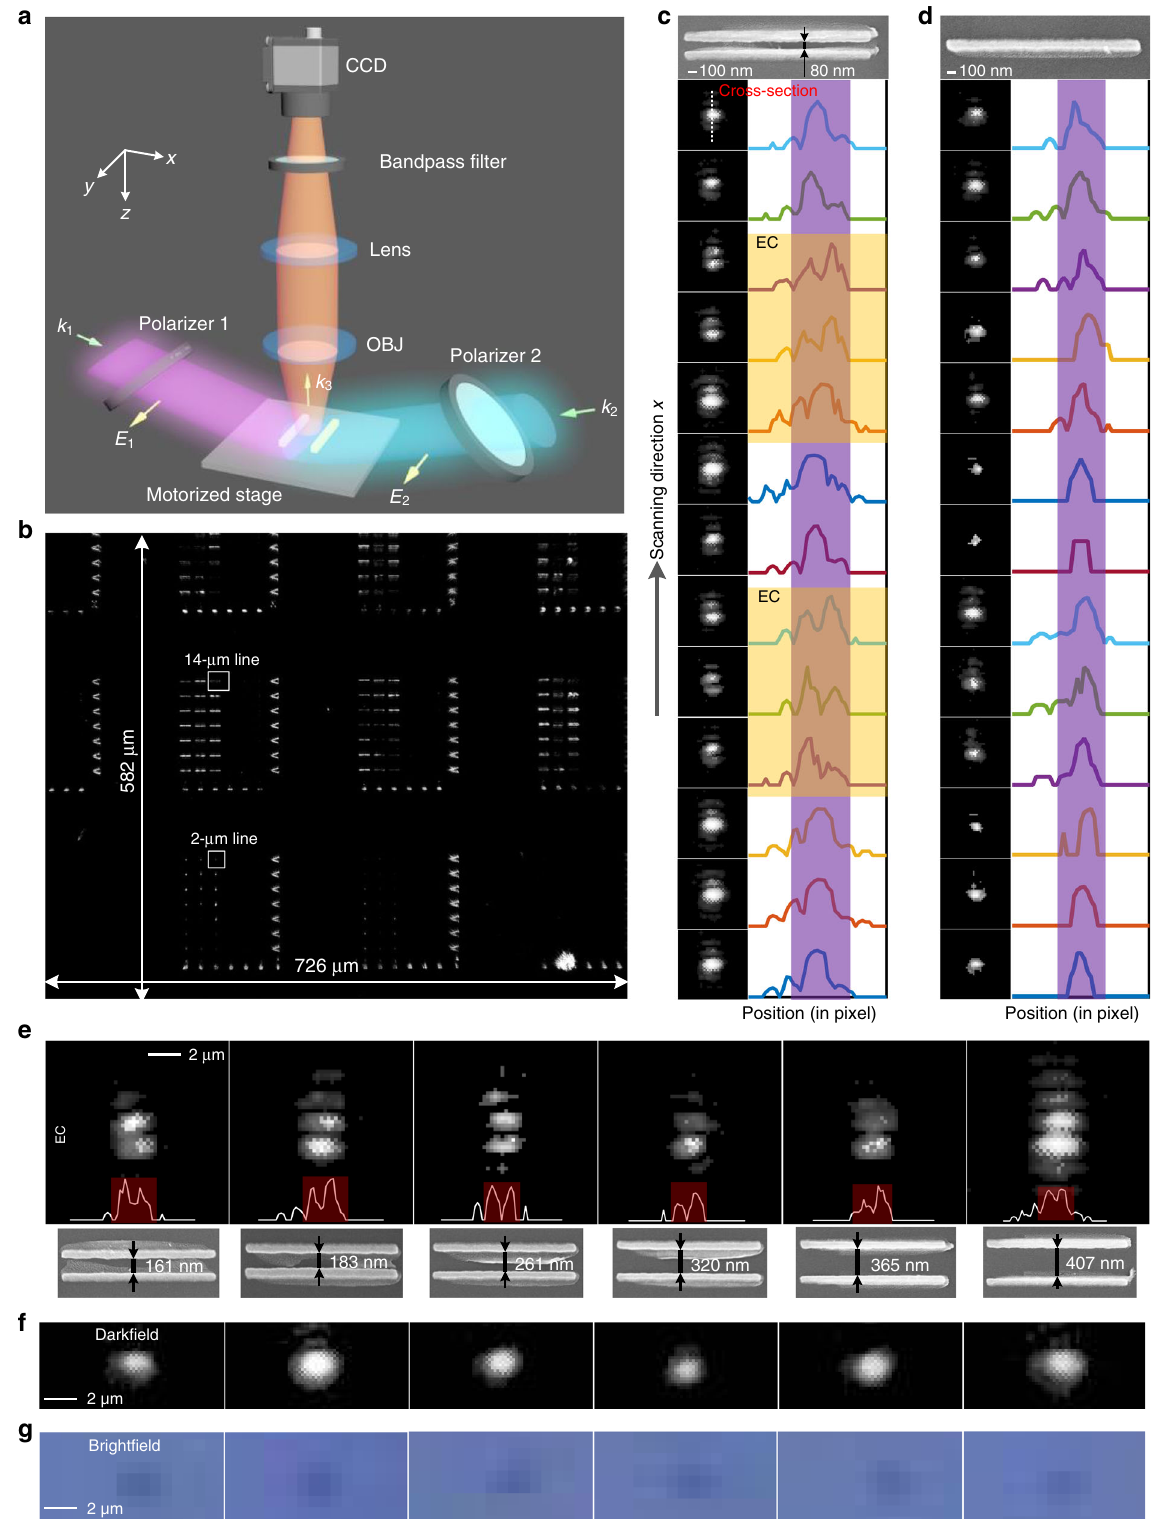
δ is the width of the object; see the inset in the 3D schematic of Fig. 5b showing the de fi nition of δ ) and a small object ( δ a = 50 nm) on the bottom left and bottom right corners, respectively. details are not visible in the non-EC image. Figure 5c presents a quad-nanowire structure with two central line-expansion objects “ a ” and “ b. ” The dimension of this type of object can be characterized by the expanded width Δ , de fi ned in the inset in